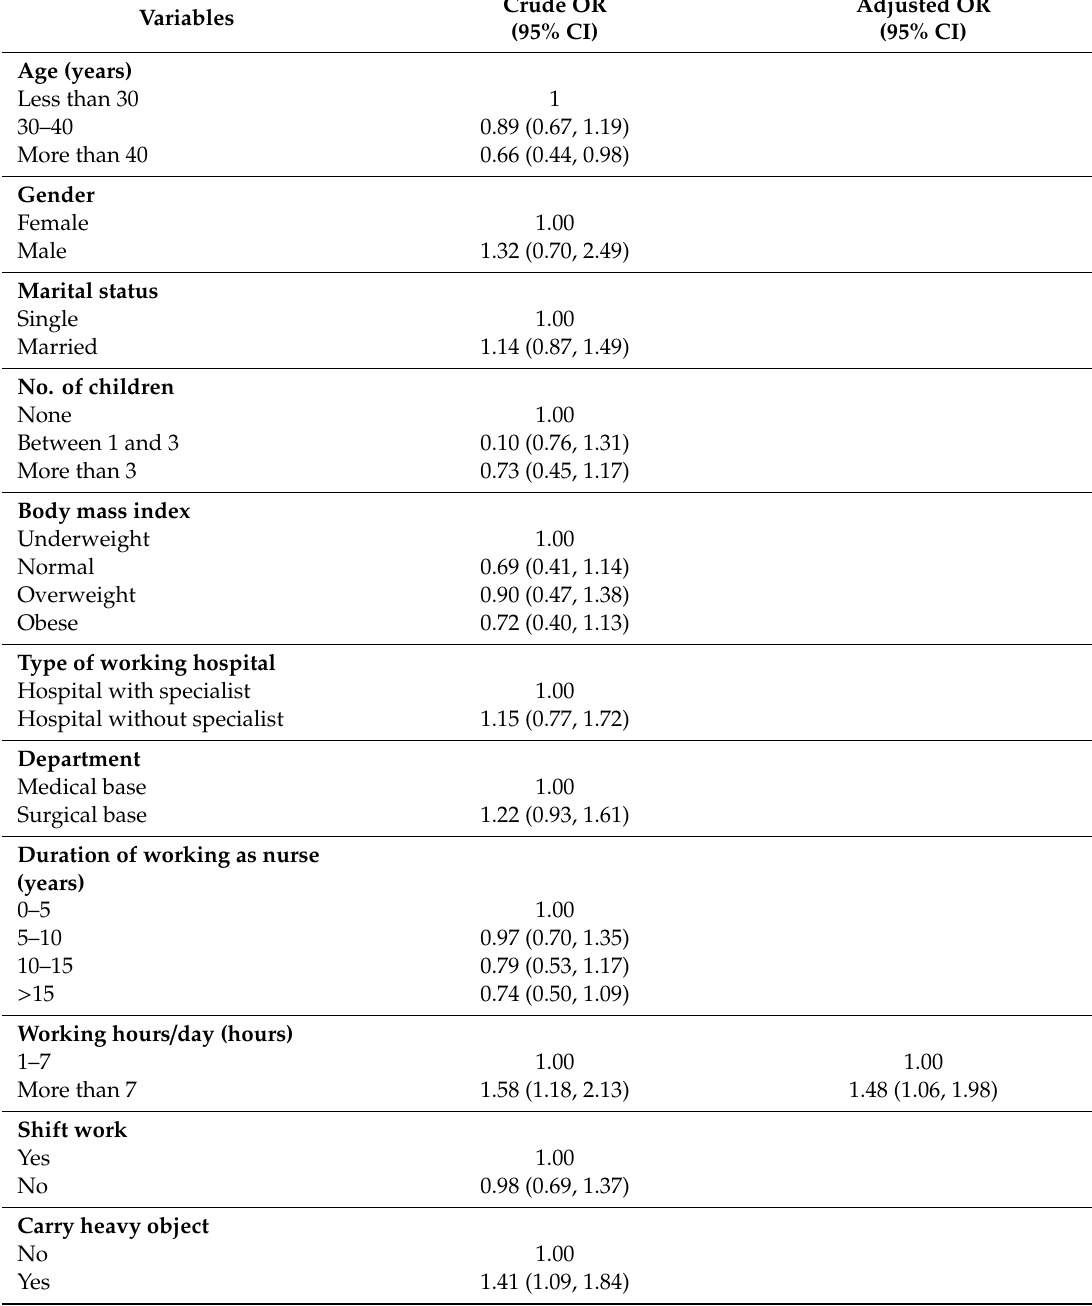
Table 5. Factors associated with low back pain (LBP) among the nurses in the public hospitals of Penang, using multiple logistic regression analysis ( n =